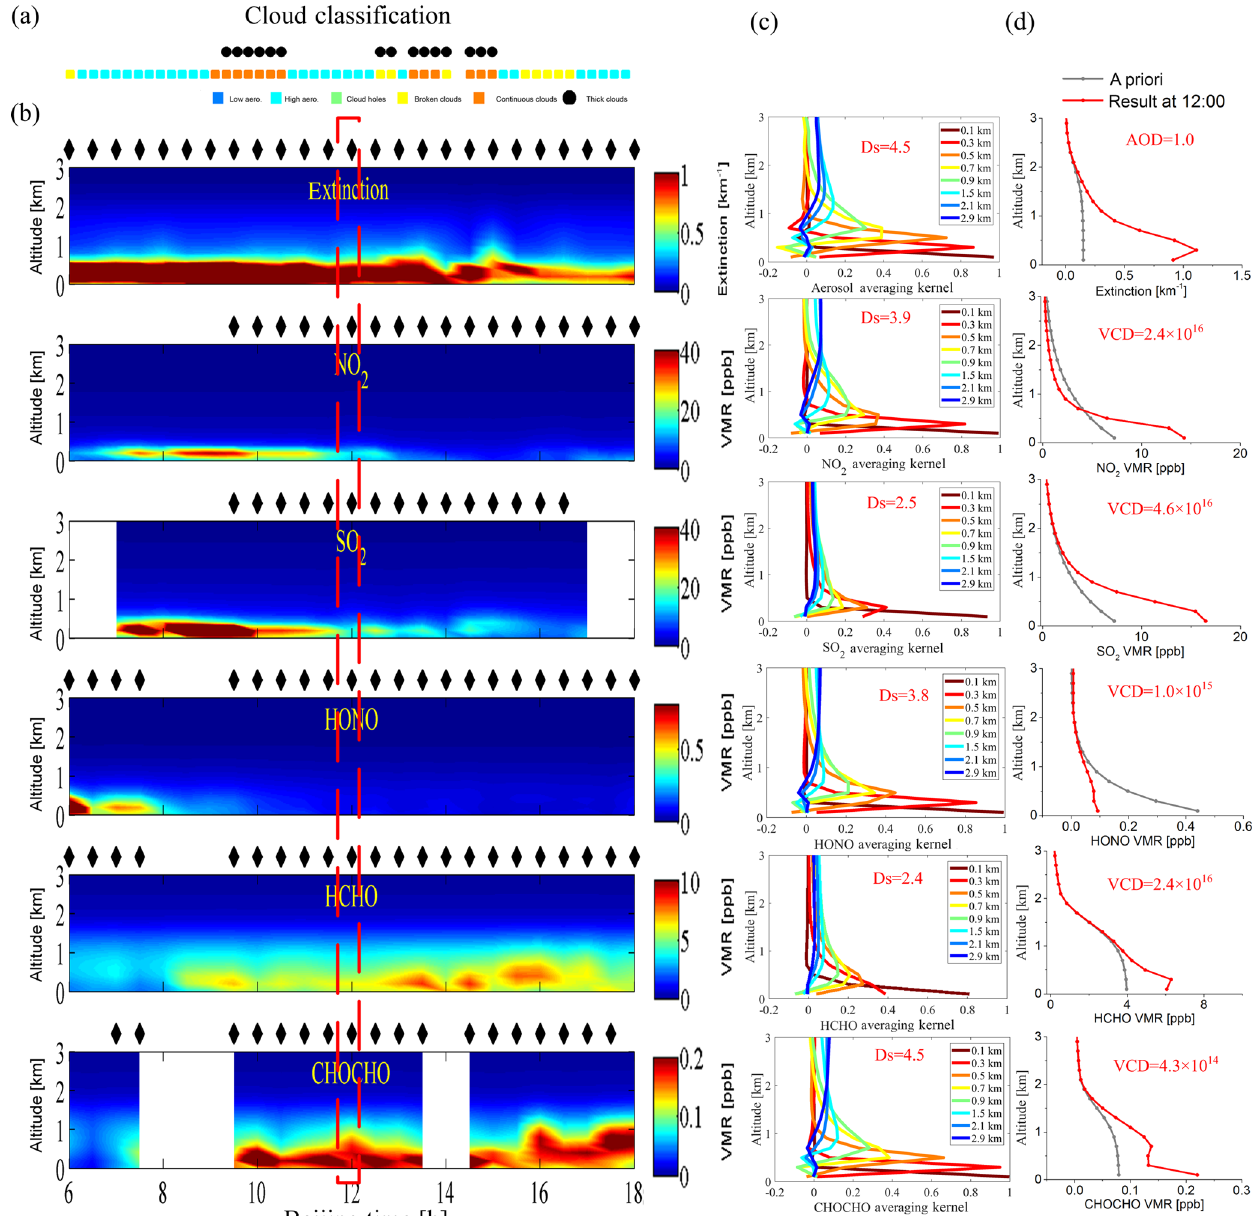
Figure 4. Examples of results derived from MAX-DOAS measurements on 11 May 2016 (with high pollution levels). (a) Cloud classifi- cation results. (b) Time series of vertical profiles of aerosol extinction (including cloud-contaminated results), NO 2 , SO 2 , HONO, HCHO and CHOCHO VMRs. The black rhombuses (diamonds) plotted above individual subfigures mark “high confidence profiles” (results with deviations between measured and simulated dSCDs smaller than the individual thresholds; see Table 2). (c) Averaging kernels ( AK ) of profile retrievals at around noon with information on the degree of freedom (ds). (d) A priori profiles and retrieved profiles (with corresponding VCDs) at around